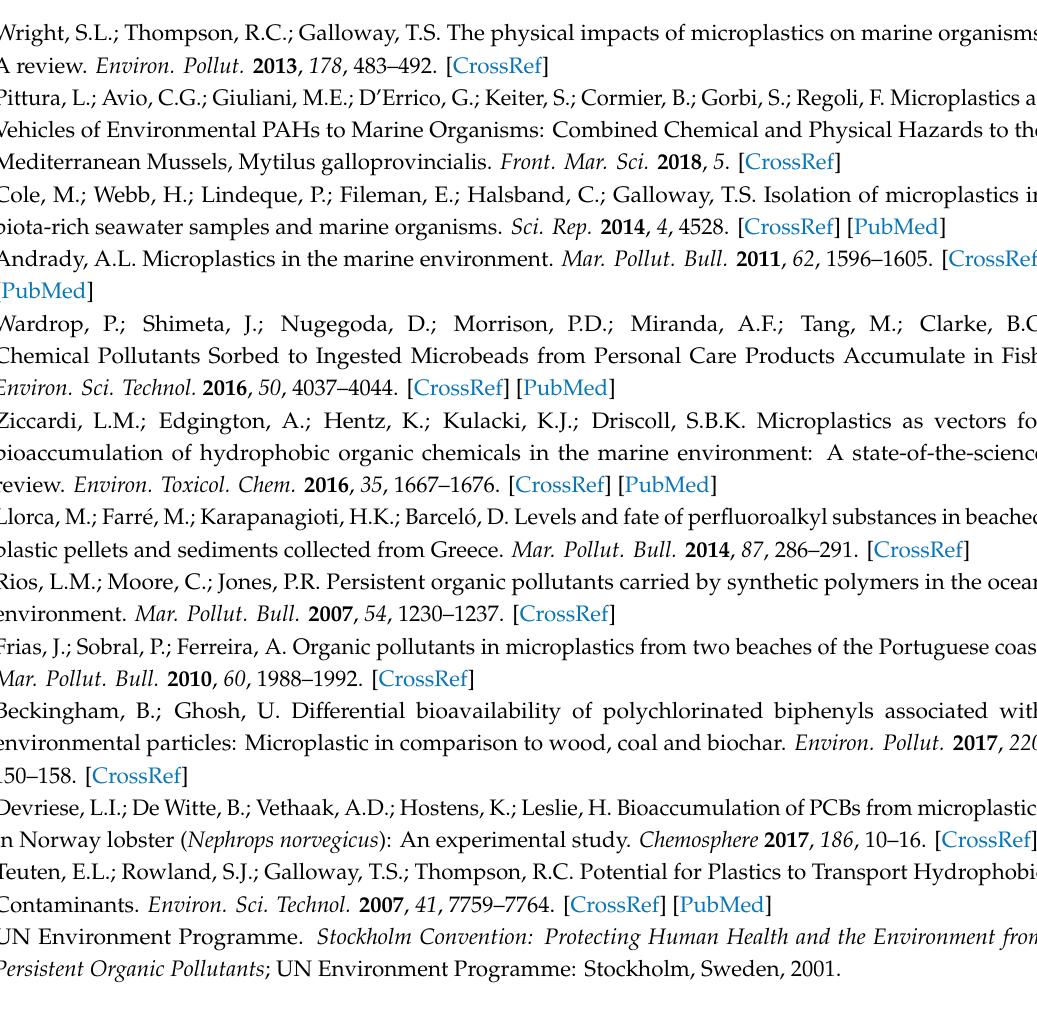
Figure S1: schematic flowchart of experimental design; Figure S2: Schematic diagram on sediment, water, and MPLs partitioning for PCBs; Figure S3: Individual adsorption isotherms of marker PCBs on (A) PS, (B) PE and (C)